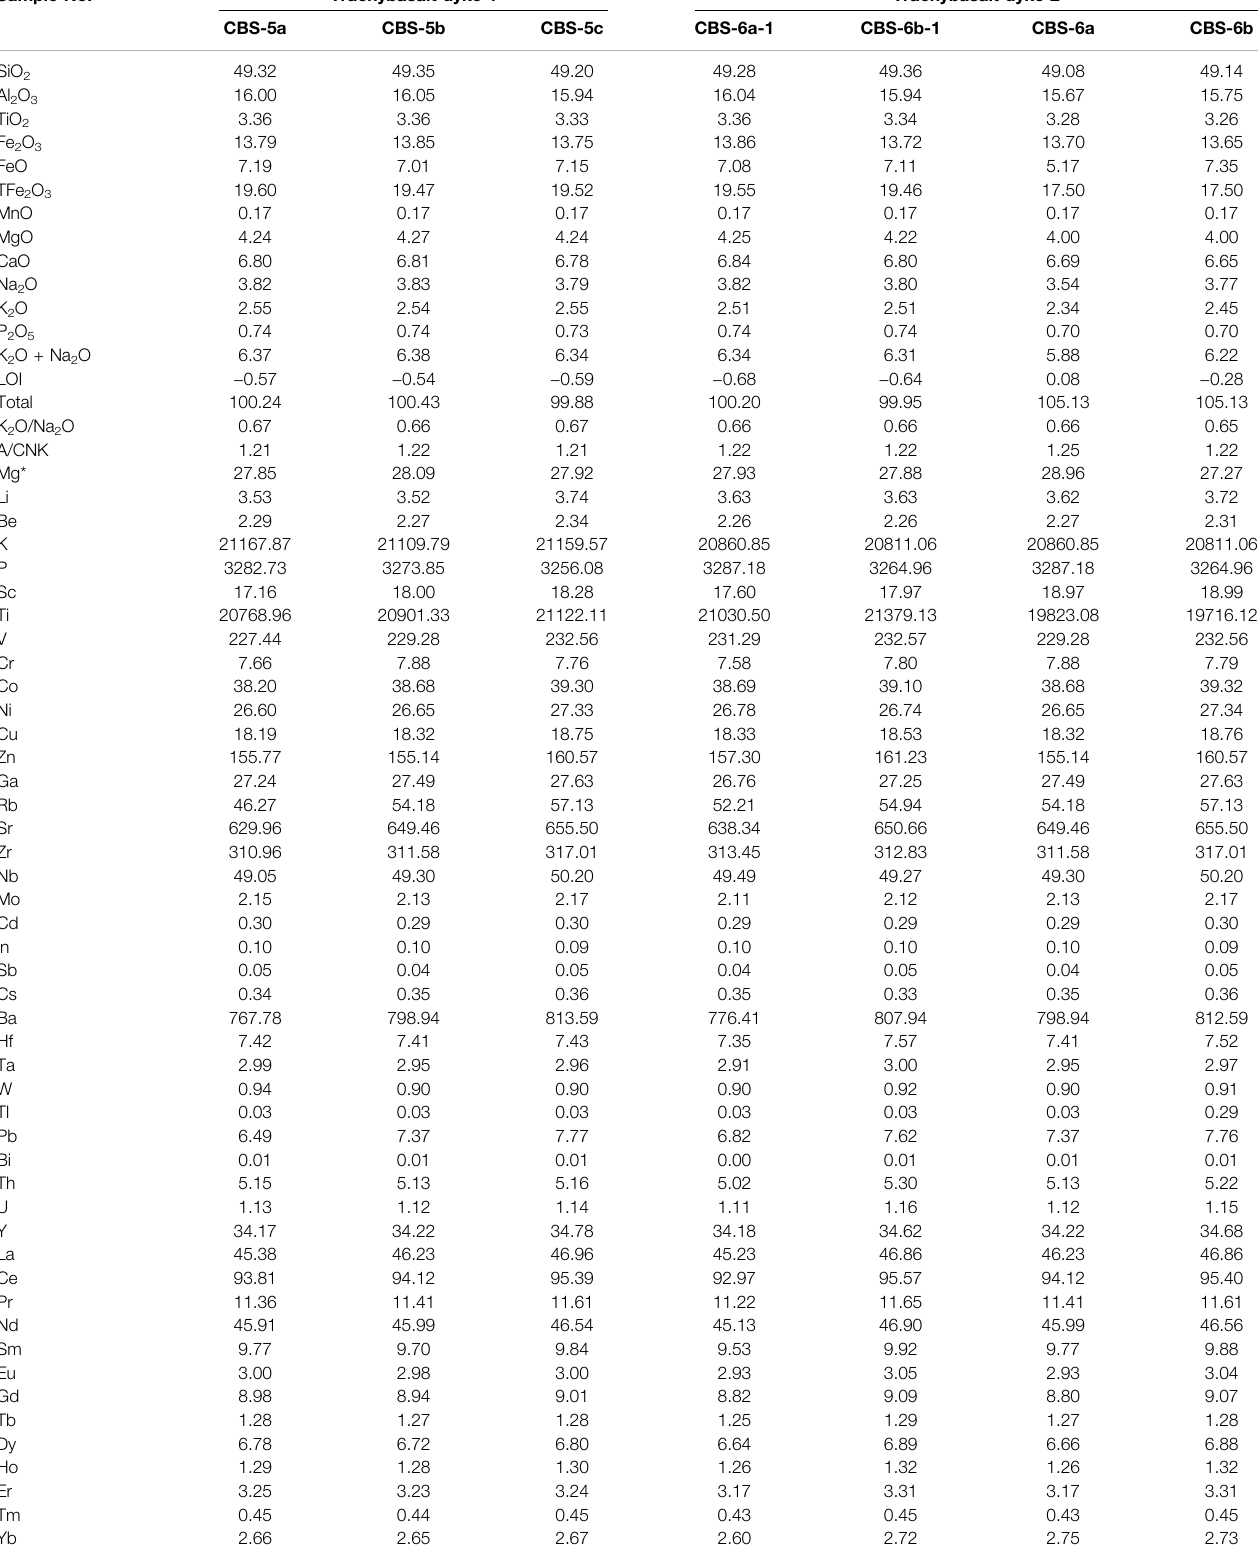
TABLE 3 | Major (wt%) and trace element (ppm) compositions of the trachybasalt dikes of the Changbai Mountain volcanic area. Sample